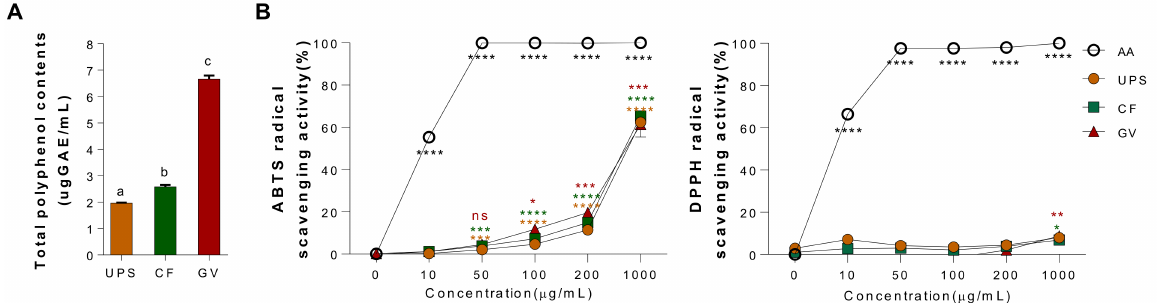
Figure 2. Total polyphenol contents and antioxidant properties of three seaweed water extracts. ( A ) Total polyphenol contents, values that do not share the same superscript are significantly different according to ANOVA ( p < 0.05), ( B ) ABTS cation radical scavenging effect and DPPH cation radical scavenging effect of UPS, CF, and GV. Data are represented as the mean ± SEM of three independent experiments. * p < 0.05; ** p < 0.01, *** p < 0.001, **** p < 0.0001 compared with control group (0 µ g/mL) using one-way ANOVA with Dunnett’s comparison test. Abbreviations: AA; ascorbic acid, UPS, Undaria pinnatifida sporophyll; CF, Codium fragile ; GV, Gracilaria